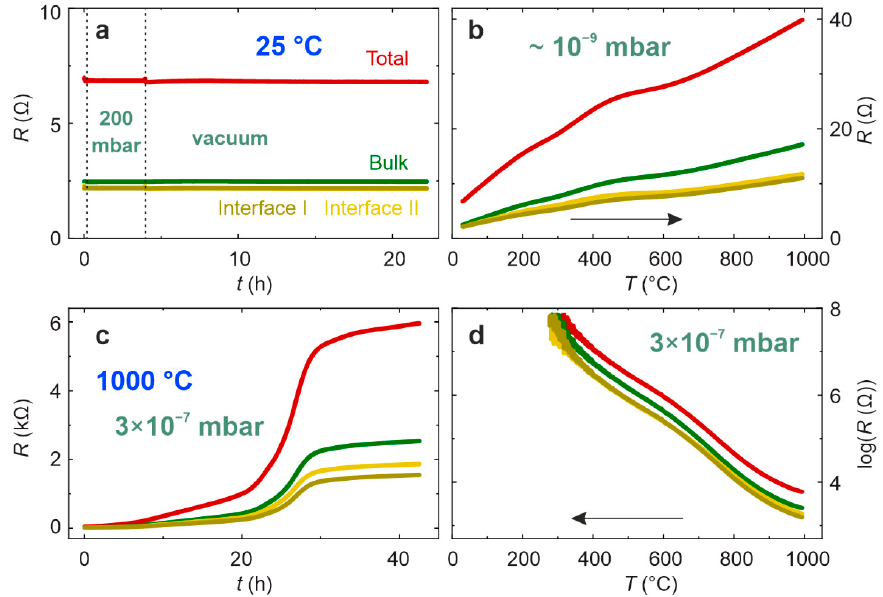
Figure 2. Resistance of the crystal during exposure to oxygen: ( a ) exposure to 200 mbar O 2 at room temperature for 4 h and subsequent re-evacuation; ( b ) heating to 1000 °C under vacuum conditions; ( c ) exposure to 3 × 10 − 7 mbar O 2 at 1000 °C; and ( d ) subsequent cooling at 3 × 10 − 7 mbar O 2 .